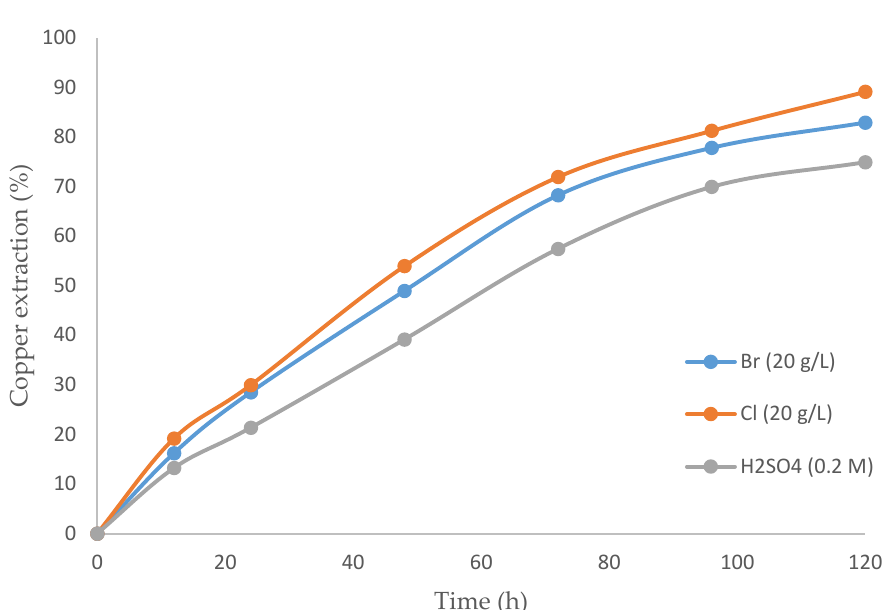
Figure 3. Copper extraction percentage over time (h) comparing: sulfuric acid with bromine, sulfuric acid with chloride, and only sulfuric acid (temperature 80 °C, 20% ( v / v ) [bmim][HSO 4 ], pulp density 10 g/L).